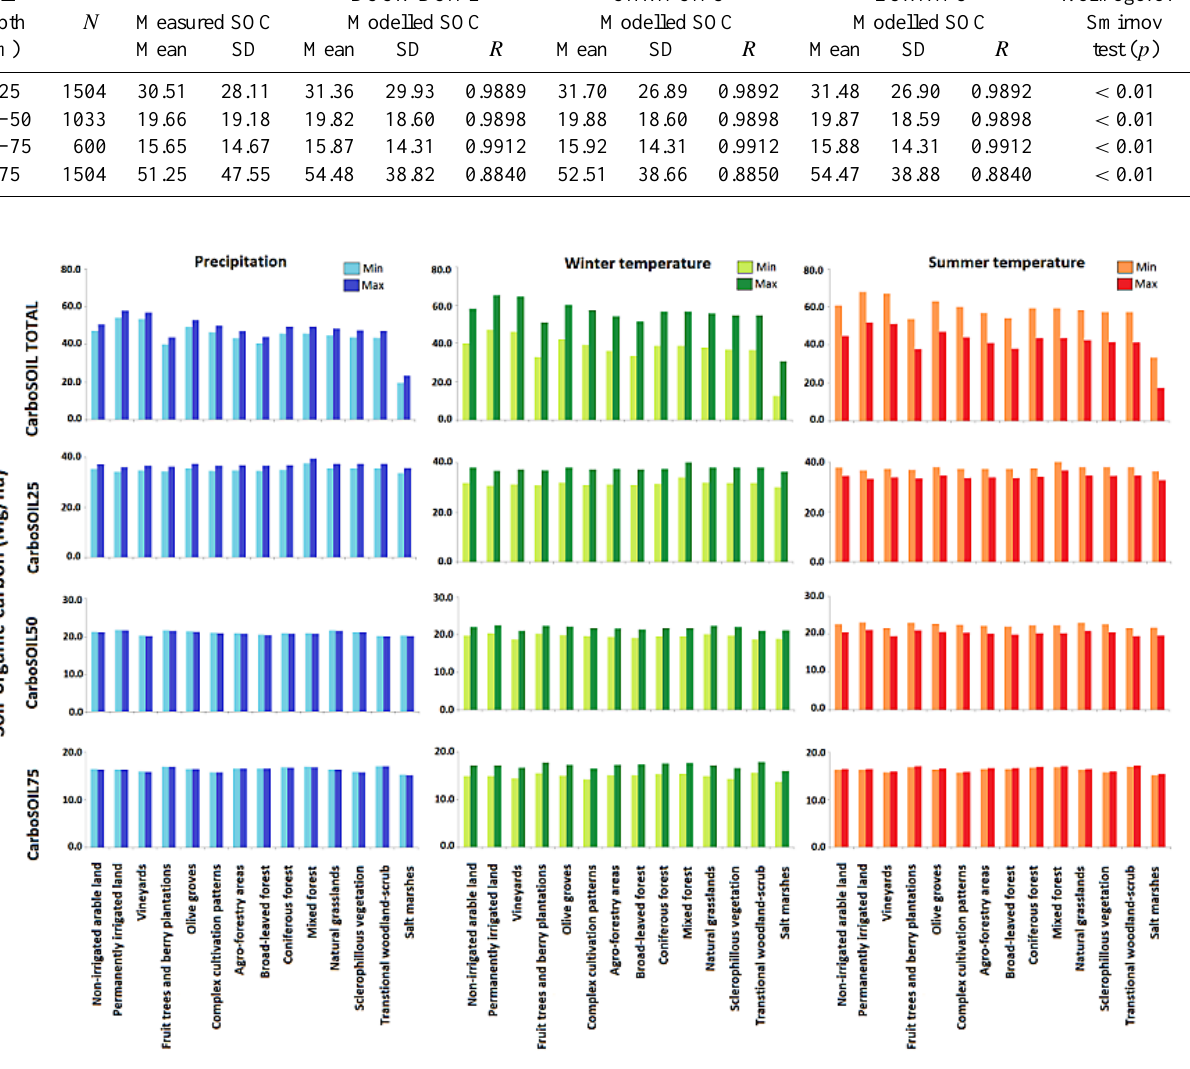
Table 4. Measured and modelled soil organic C (SOC) content (Mgha − 1 ) under current scenario (baseline scenarios according to BCCR- BCM2 , CNRMCM3 and ECHAM5), and results of the Kolmogorov–Smirnov test. All correlations are significant at the 0.01 level.